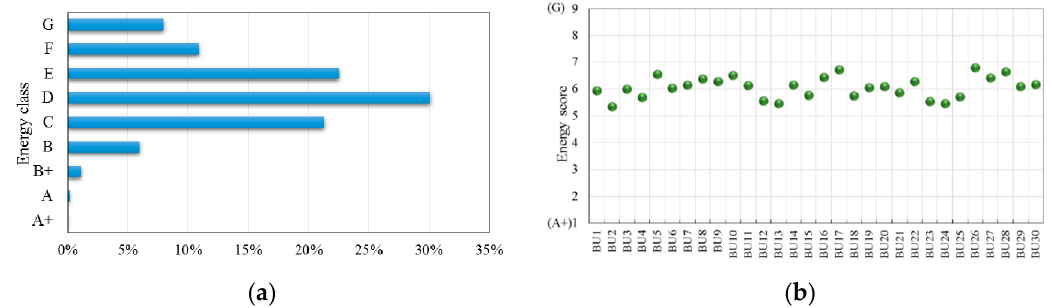
Figure 6. The distribution of NR buildings in energy classes ( a ) and the weighted energy score of NR buildings ( b ).